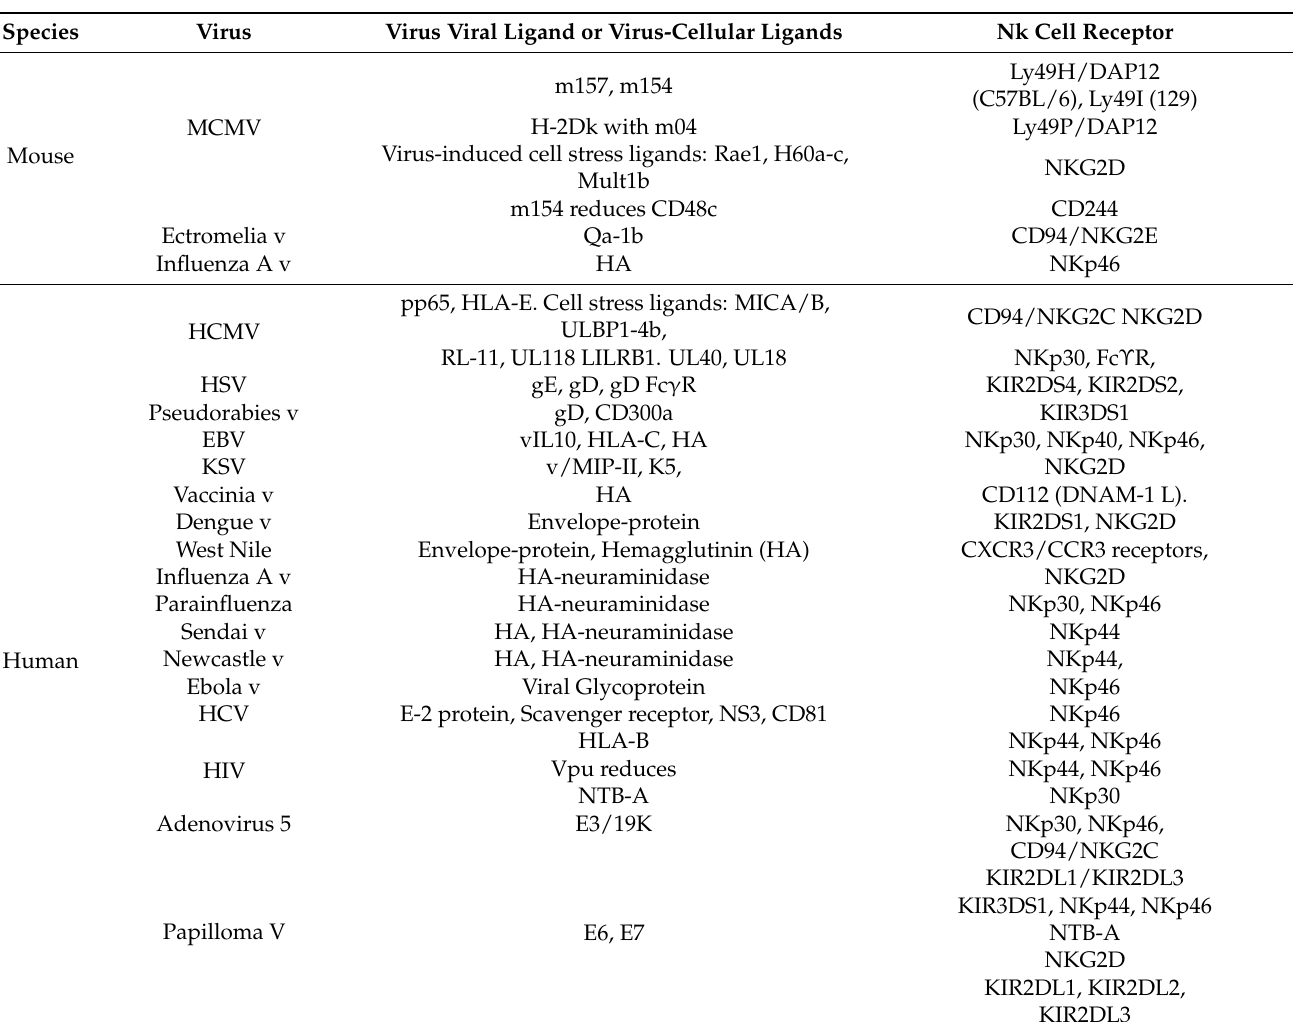
Table 2. Viral antigens and NK receptors in different viral